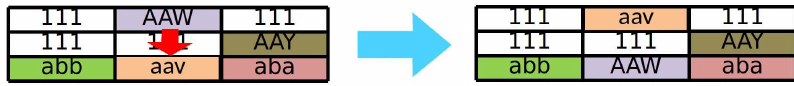
Figure 7. Fourth neighborhood